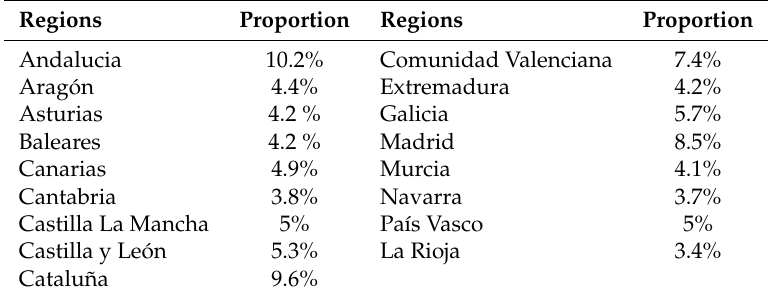
Table 2. Proportions used by the Spanish Center of Sociological Research to obtain regional sample